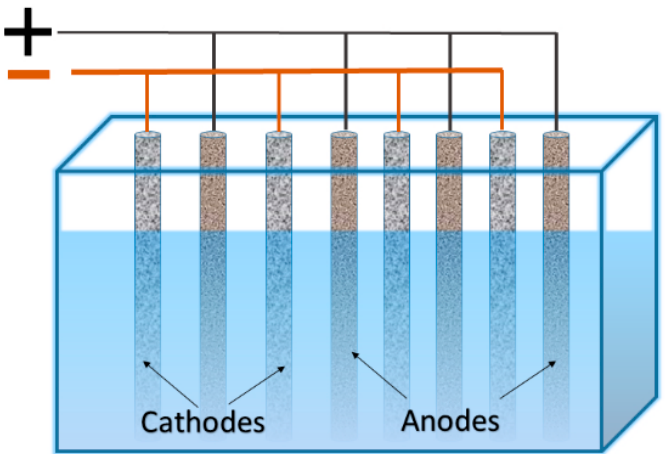
Figure 1. Arrangement of cathodes and anodes in “sandwich” configuration.